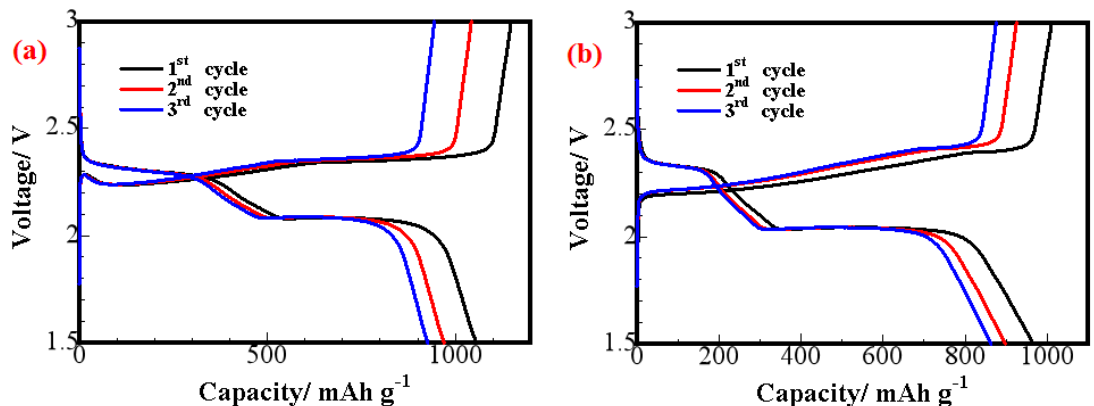
Figure 9. Charging/discharging curves of the lithium – sulfur batteries with the ( a ) S/CeO 2 /RGO and ( b ) S/RGO cathodes at 0.1 C. ( b ) S/RGO cathodes at 0.1 C.